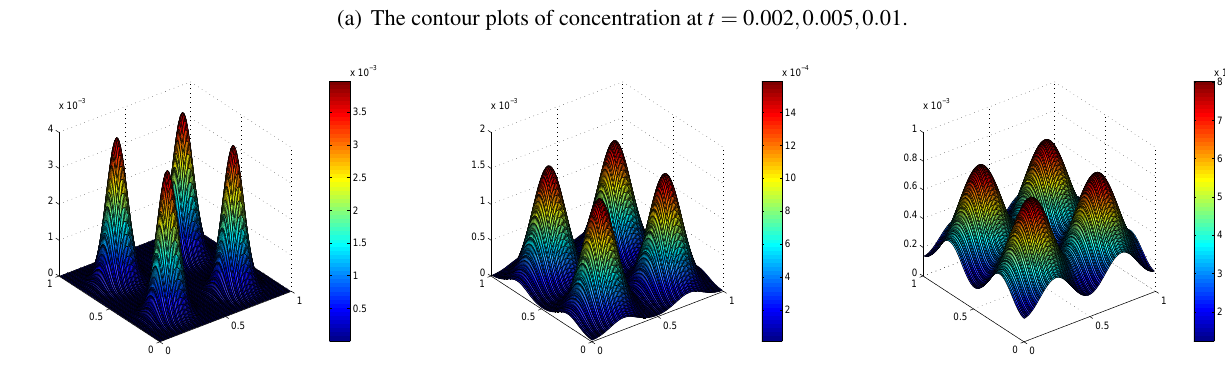
(b) The surface plots of concentration at t = 0 . 002 , 0 . 005 , 0 . 01. Fig. 2 The numerical simulation for heat